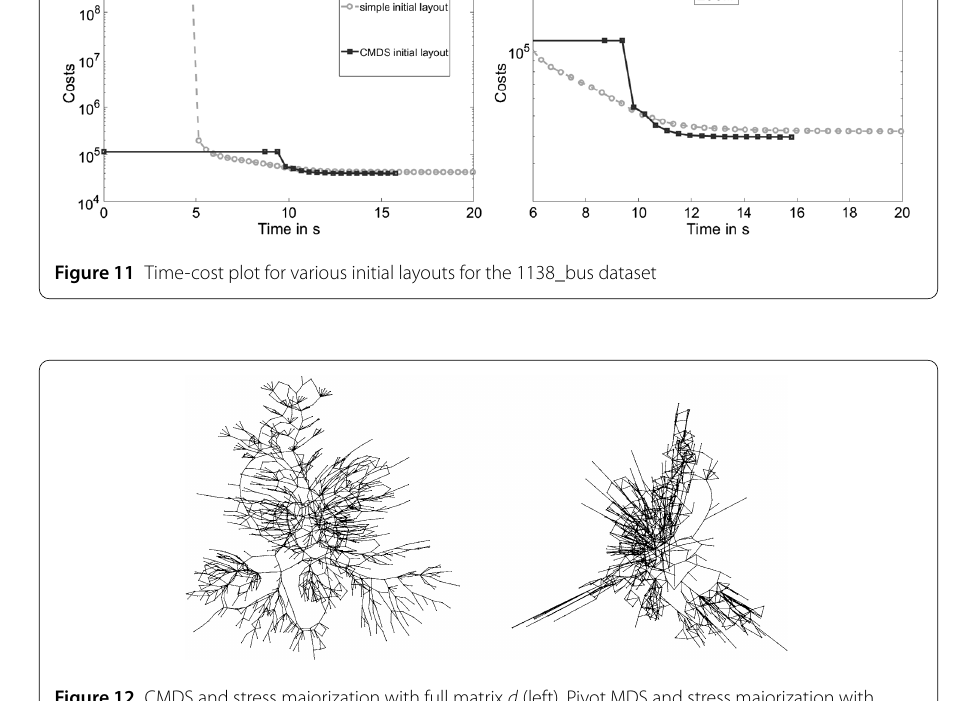
Figure 12 CMDS and stress majorization with full matrix d (left), Pivot MDS and stress majorization with sparse matrix d (right) applied to the 1138_bus